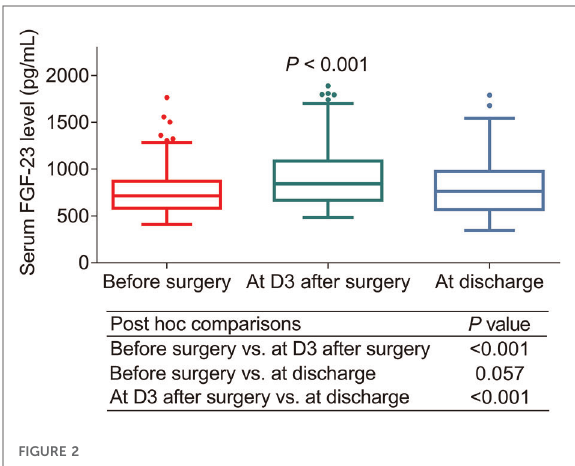
(before surgery) high and low groups. It was found that the cumulative MACCE rate was increased in the FGF-23 (before surgery) high group compared to the FGF-23 (before surgery) low group ( P = 0.028) ( Figure 3 ). Speci fi cally, the 1-year, 2- year, and 3-year cumulative MACCE rate in FGF-23 (before